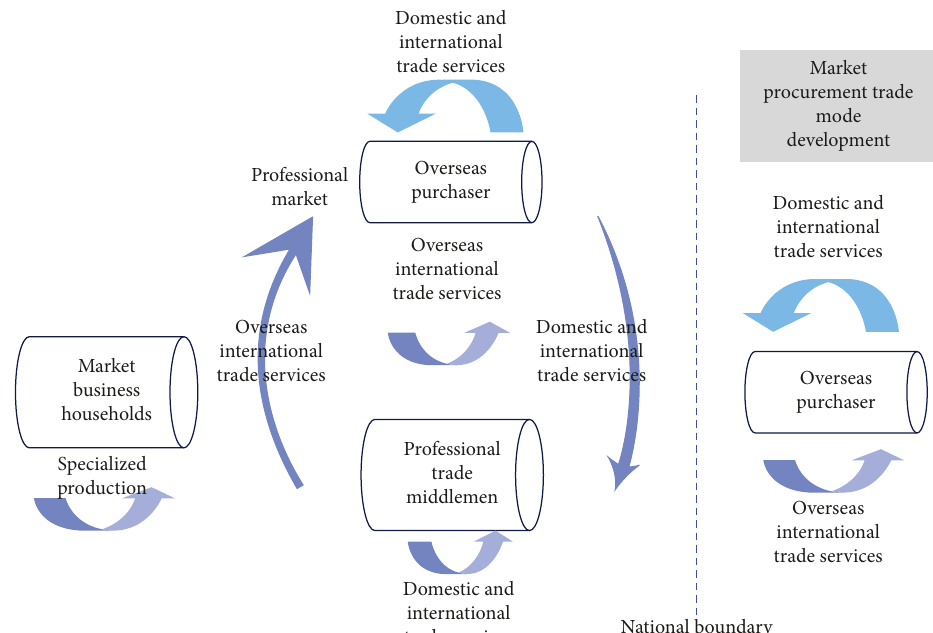
Figure 8: The development period of purchasing and trading methods in the small commodity market.